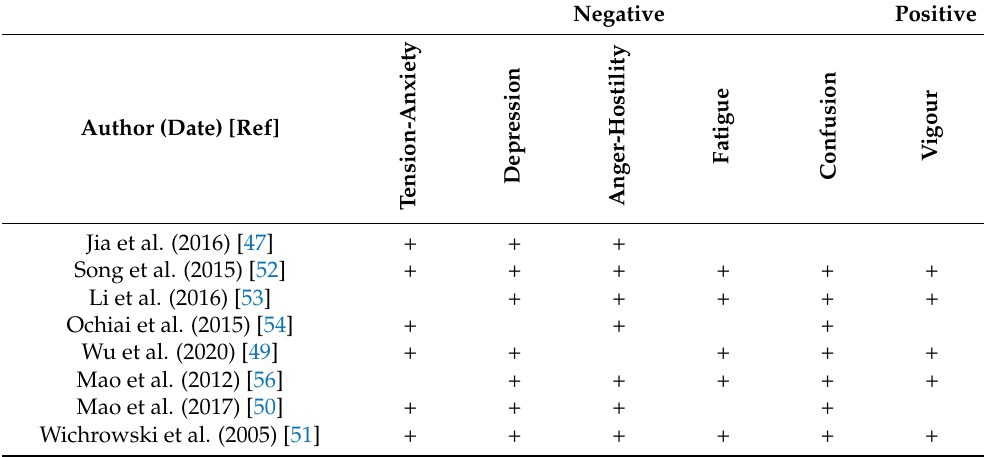
Table 4. Summary of POMS positive outcomes after the intervention (decreased negative, increased positive) by domain. + denotes this domain was significantly improved following the